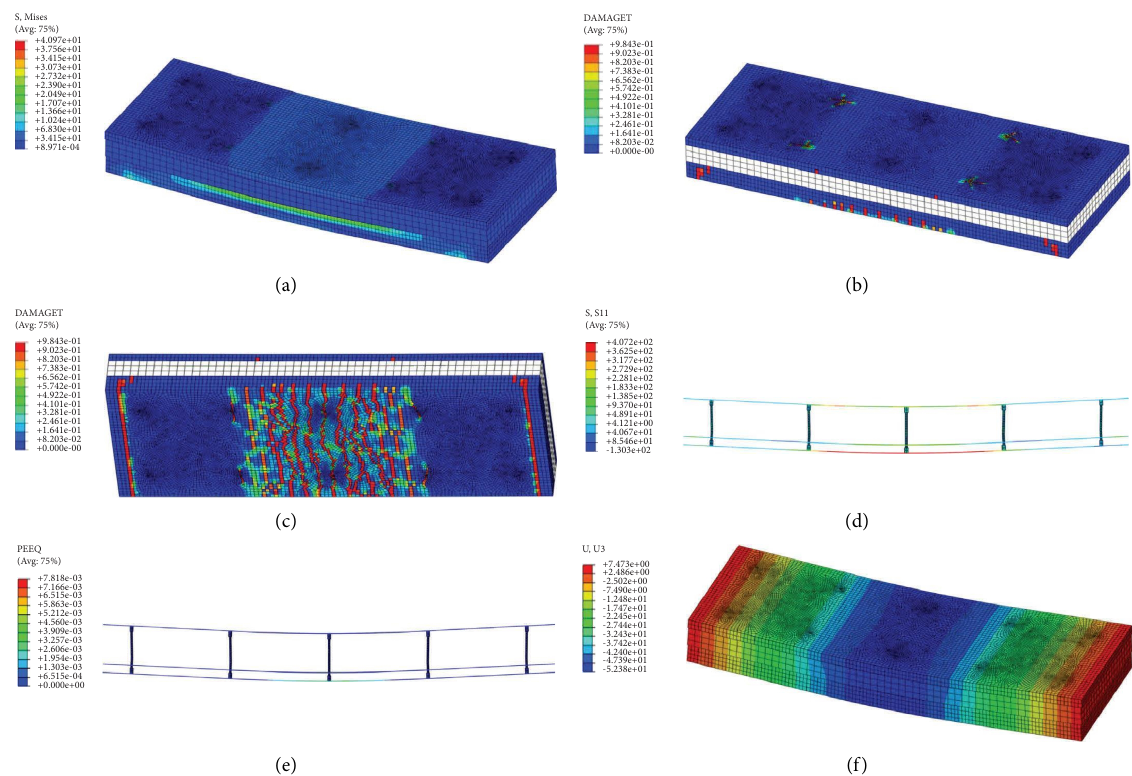
Figure 12: Simulated damage and contours of stress, strain, and displacement of G24-I at failure. (a) Stress contour of G24-I, (b) tension damage of G24-I, (c) tension damage on bottom wythe of G24-I, (d) stress contour of steel mesh of G24-I, (e) strain contour of steel mesh of G24-I, and (f) displacement contour of